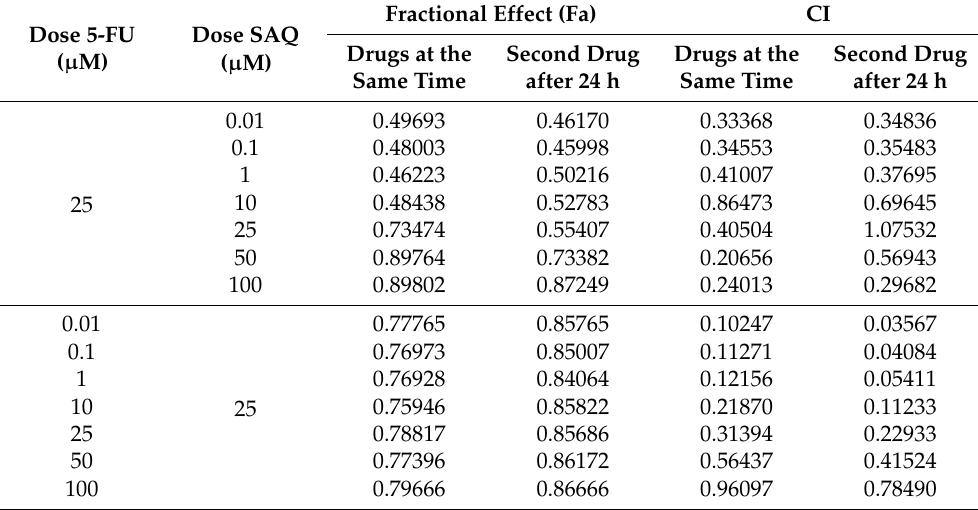
Table 2. Effect and CI values of 5-FU and SAQ combinations simultaneously or with the second drug being added after 24 h. CI < 1 represents synergism, CI = 1 represents additivity, and CI > 1 represents antagonism. The fractional effect shows the degree of cell death, ranging from 0 to 1, with 0 being no cellular death and 1 being total cellular